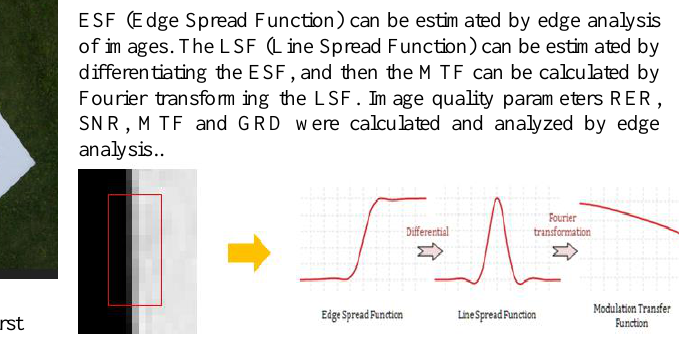
Figure 3. ESF, LSF and